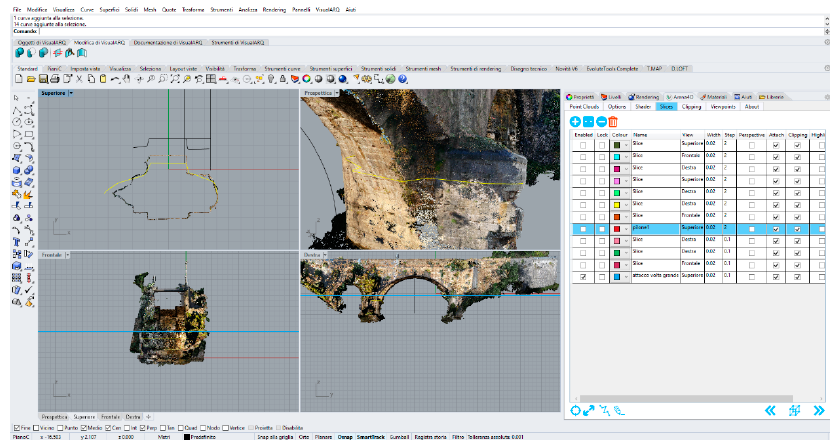
Figure 10. Construction planes within Rhinoceros software. Appl. Sci. 2020 , 10 , x FOR PEER REVIEW